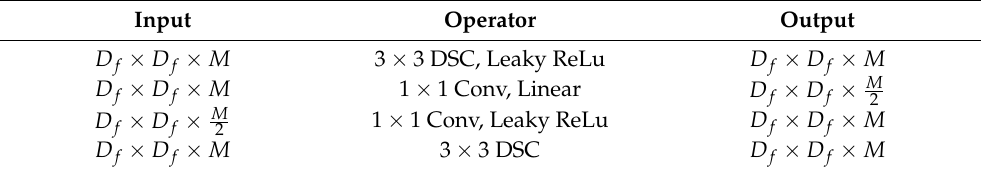
Table 2. The operation of the SandGlass-L